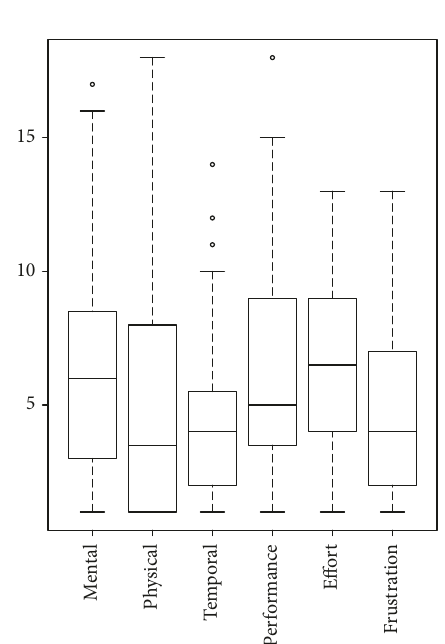
∘ refers to outliers.